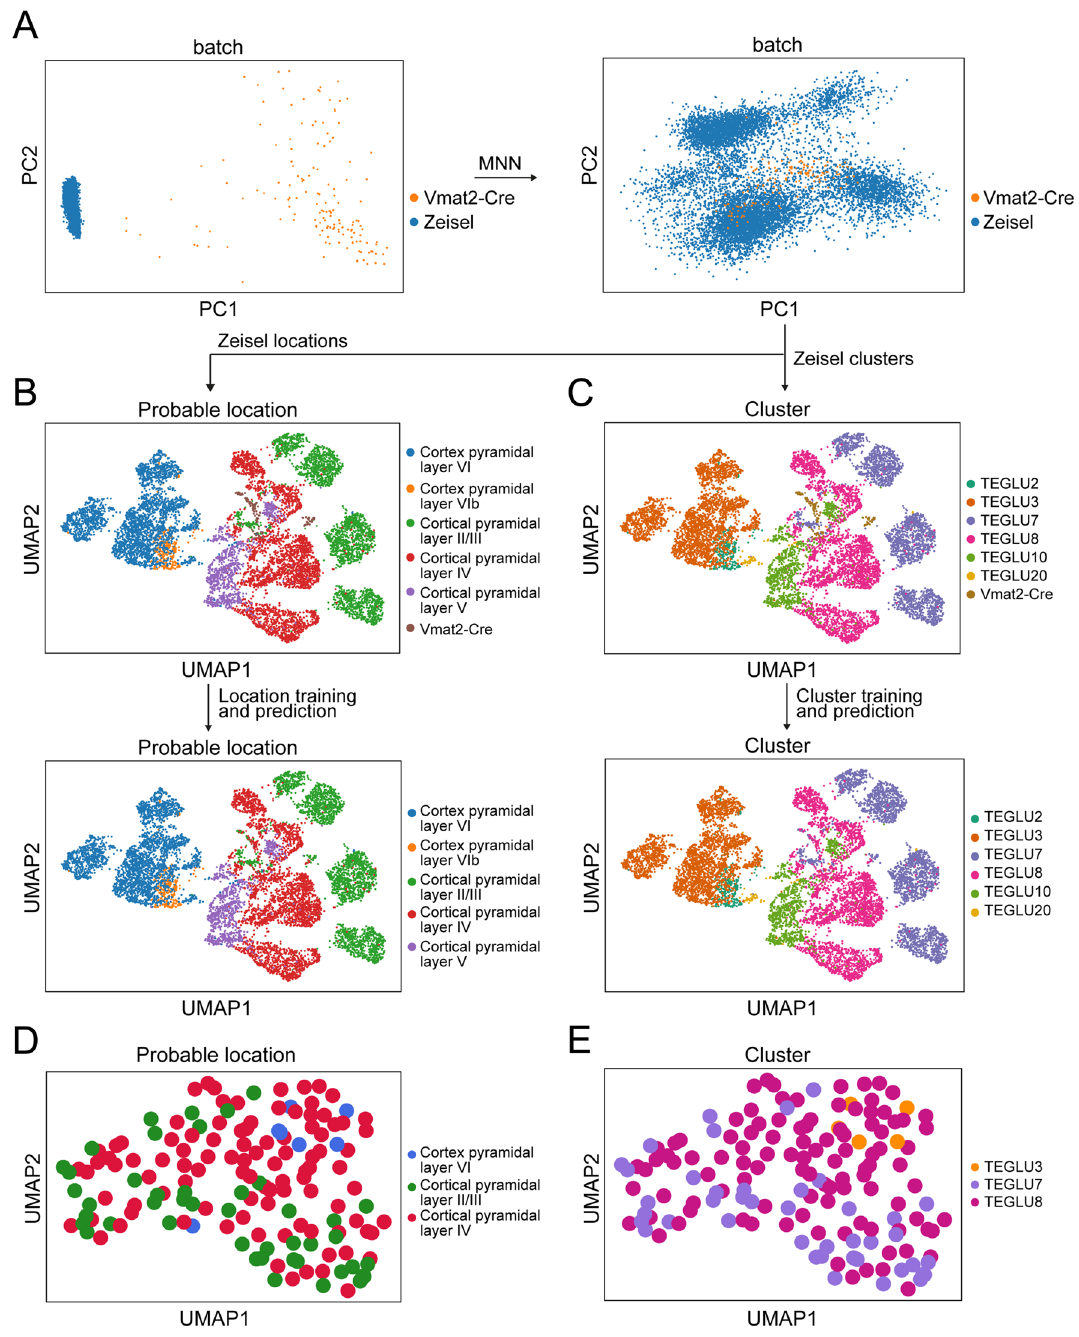
Figure 5. The Vmat2-Cre; tdTomato population is mainly located in layer IV. ( A ) The Vmat2-Cre single cell sequencing data was merged with the Zeisel et al. telencephalon projecting cortical dataset to molecularly predict the location and cluster of the Vmat2-Cre; tdTomato population. Mutual nearest neighbors (MNN) was used to correct for gene expression caused by batch effects. ( B ) A stochastic gradient descent (SGD) classifier was trained on the Zeisel et al. dataset to predict the possible location of the Vmat2-Cre cells. ( C ) The Zeisel et al. cluster annotations of the Vmat2-Cre neurons were predicted using a SGD Classifier. ( D–E ) Replotting of the Vmat2-Cre population with Zeisel et al. annotated locations ( D ) and clusters ( E ). The images ( A–E ) were generated using SCANPY, https ://scanp y.readt hedoc s.io/en/stabl